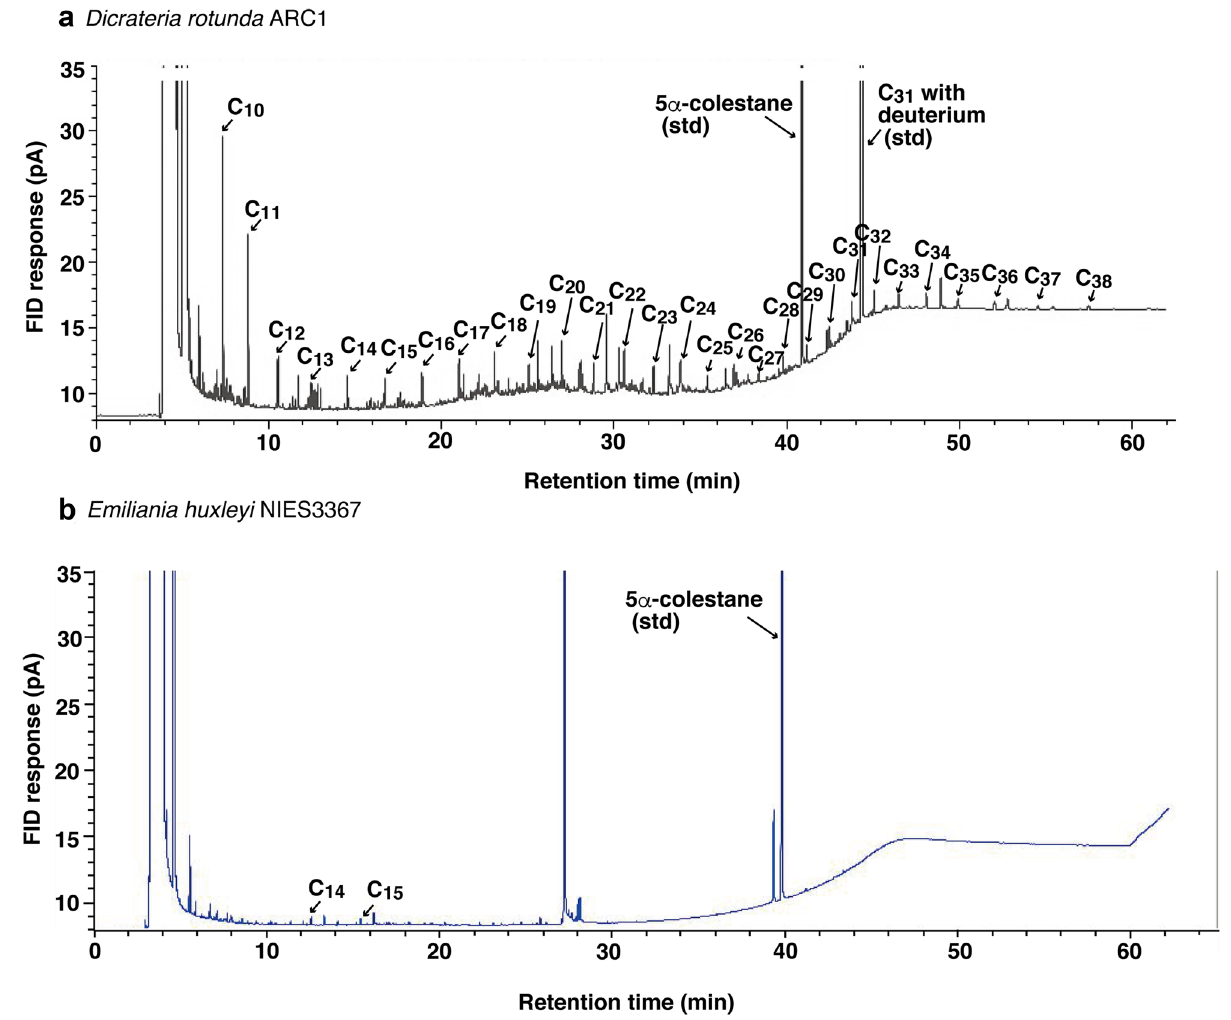
Figure 2. Gas chromatograms. ( a ) A series of alkanes from D. rotunda ARC1 strain and ( b ) Emiliania huxleyi NIES3367 strain .